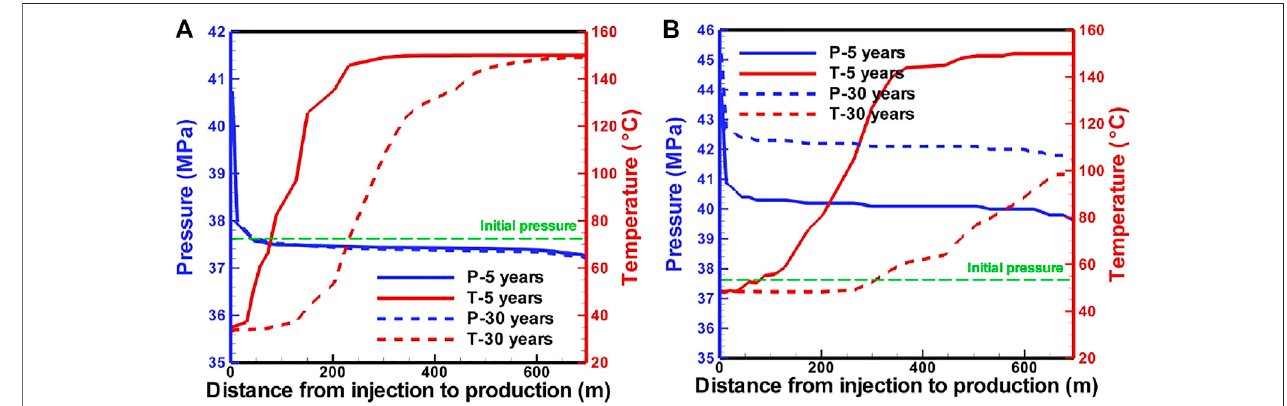
FIGURE6| Pressureandtemperature pro fi lesalongalinefromtheinjectionwelltotheproductionwellinthereservoirfor (A) H 2 O-basedand (B) CO 2 -basedEGS.